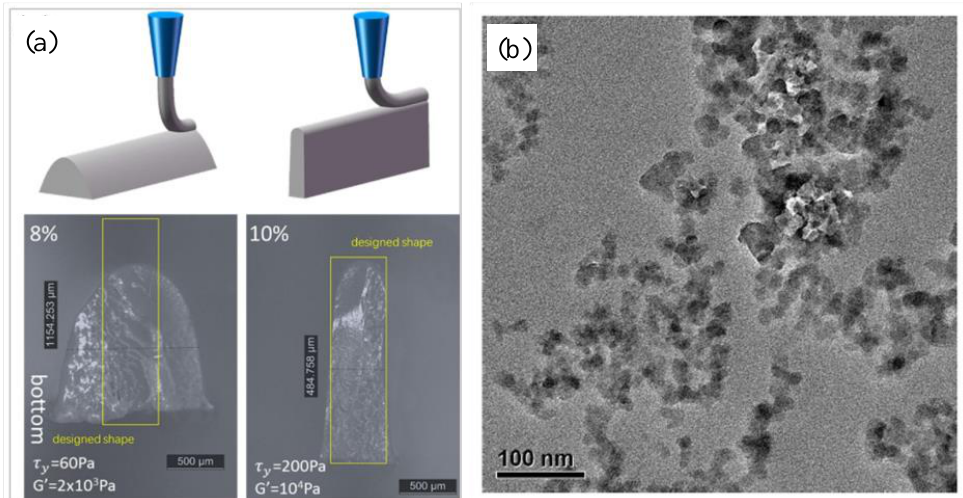
Figure 18. ( a ) Sketches and optical images of 4D-printed epoxy resin filled with 8 wt% and 10 wt% nanosilica, ( b ) transmission electron microscope micrograph shows nanosilica dispersion [189]. Copyright © 2022 Elsevier.